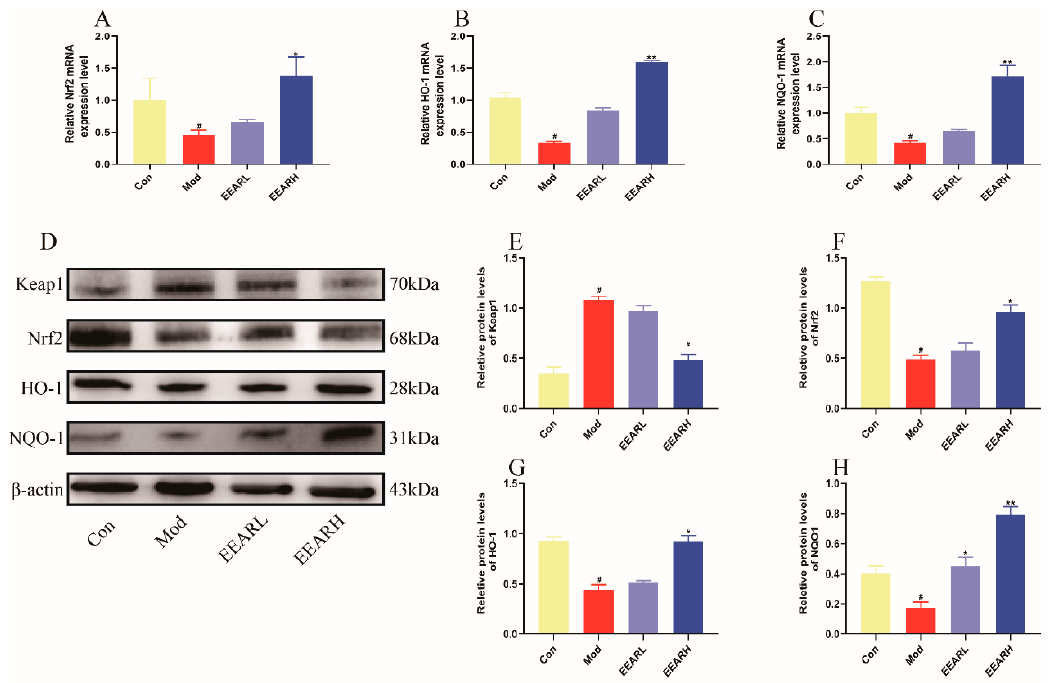
Figure 9. EEAR alleviated LPS-induced oxidative stress in THP-1 cells via the Keap1/Nrf2 signaling pathway ( n = 3). Relative ( A ) Nrf2, ( B ) HO-1, and ( C ) NQO-1 expression in cells was evaluated by RT-qPCR. ( D ) Keap1/Nrf2 signaling pathway expression levels in cells were measured by Western blot analysis. ( E ) Quantitative analysis of differences in Keap1 levels in each group. ( F ) Quantitative analysis of differences in Nrf2 levels in each group. ( G ) Quantitative analysis of differences in HO-1 levels in each group. ( H ) Quantitative analysis of differences in NQO-1 levels in each group. Values are expressed as means ± SEM. # p < 0.05 vs. Control; ** p < 0.01 vs. Model; * p < 0.05 vs. Model.